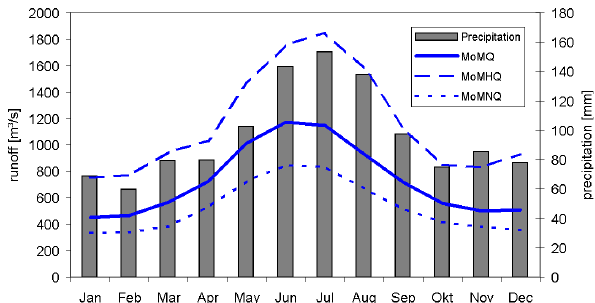
Fig. 2. Observed mean monthly discharge (MoMQ), mean monthly high flow (MoMHQ) and mean monthly low flow (MoMNQ) at the exit gauge Passau-Ingling and average monthly precipitation for the Inn River basin (period